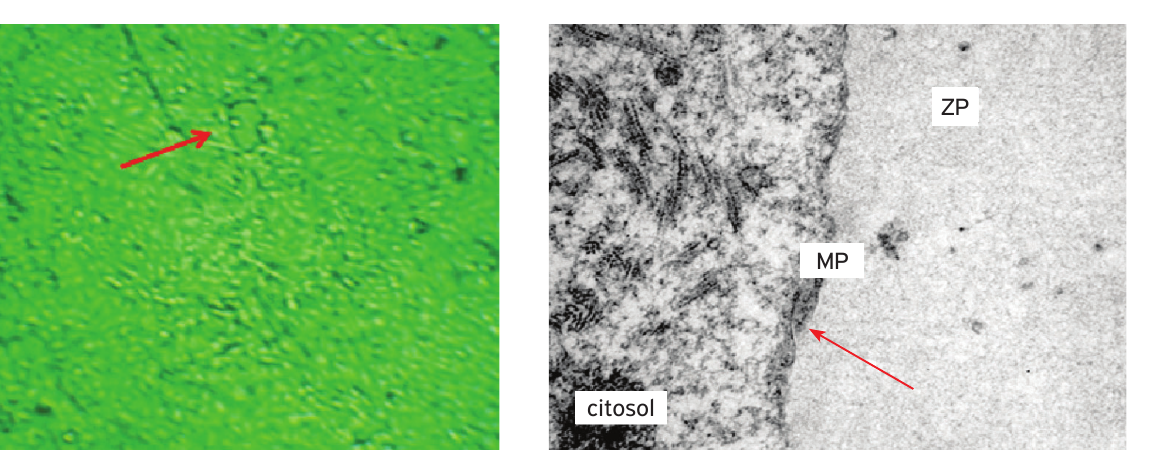
Figura 10. Embrião exposto aos vírus (Grupo G pelúcida; MP: membrana plasmática. Note (seta) perturbação da membrana plasmática. Aumento: